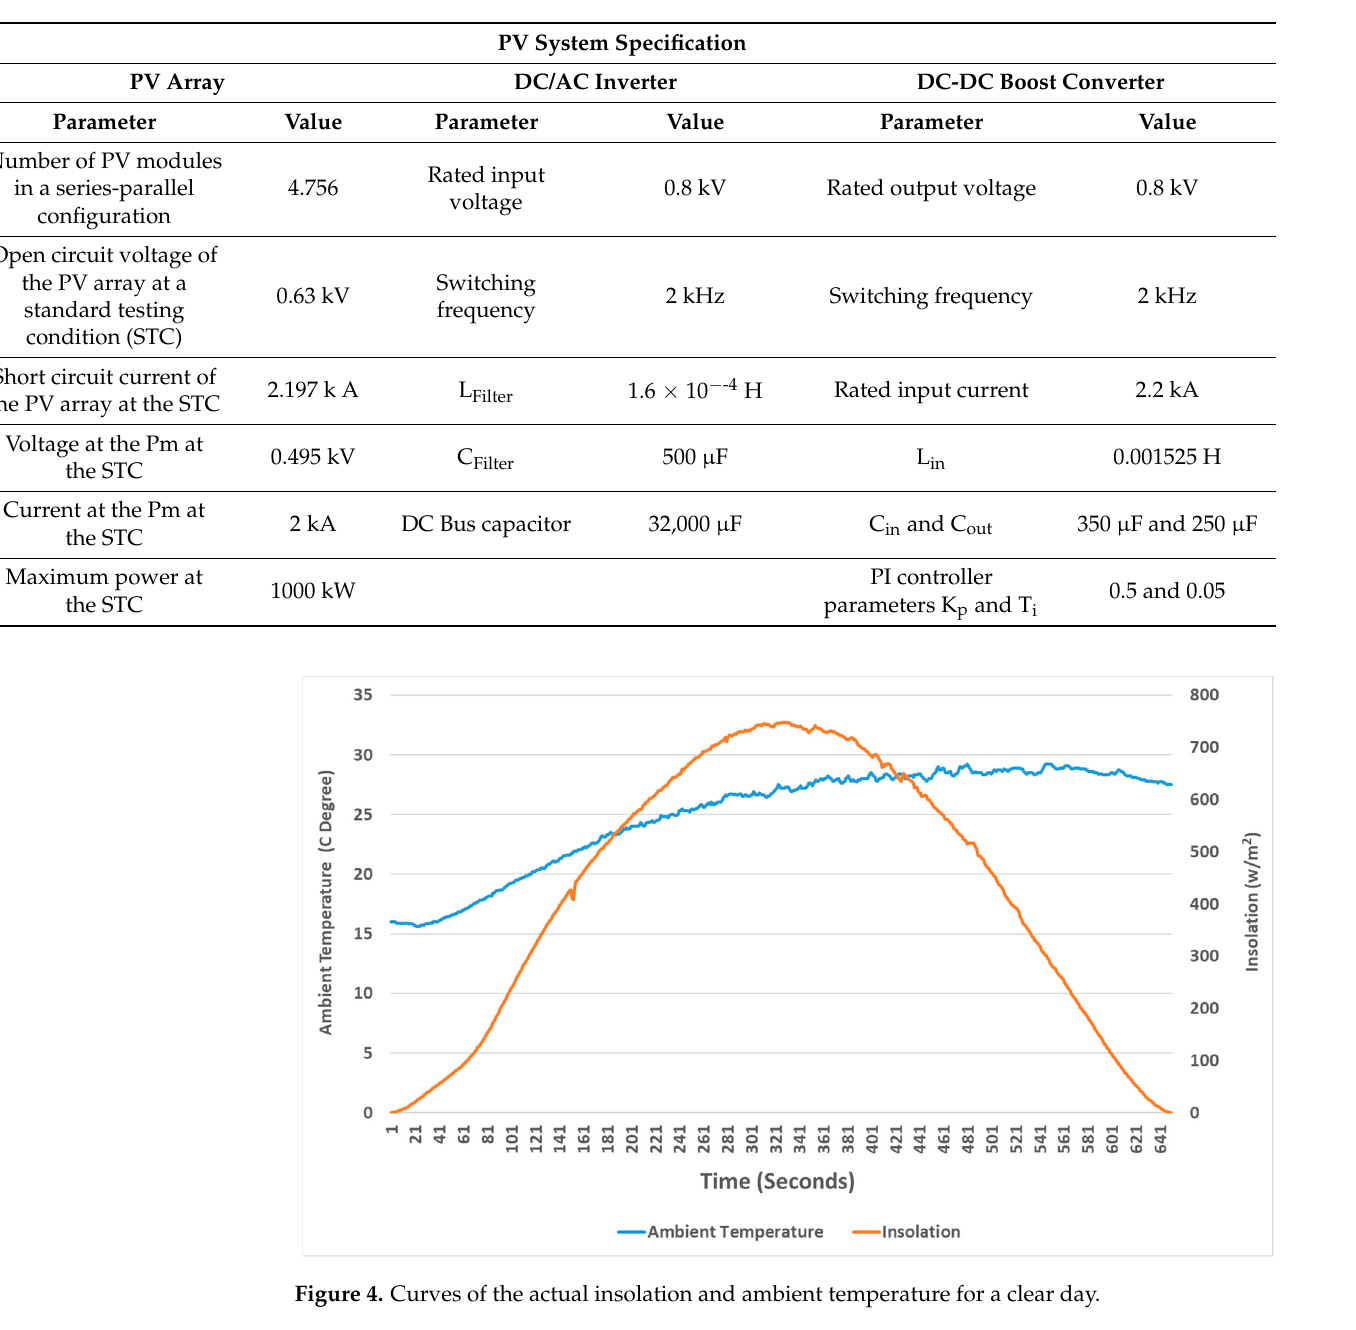
Table 1. Grid-connected PV system specifications.